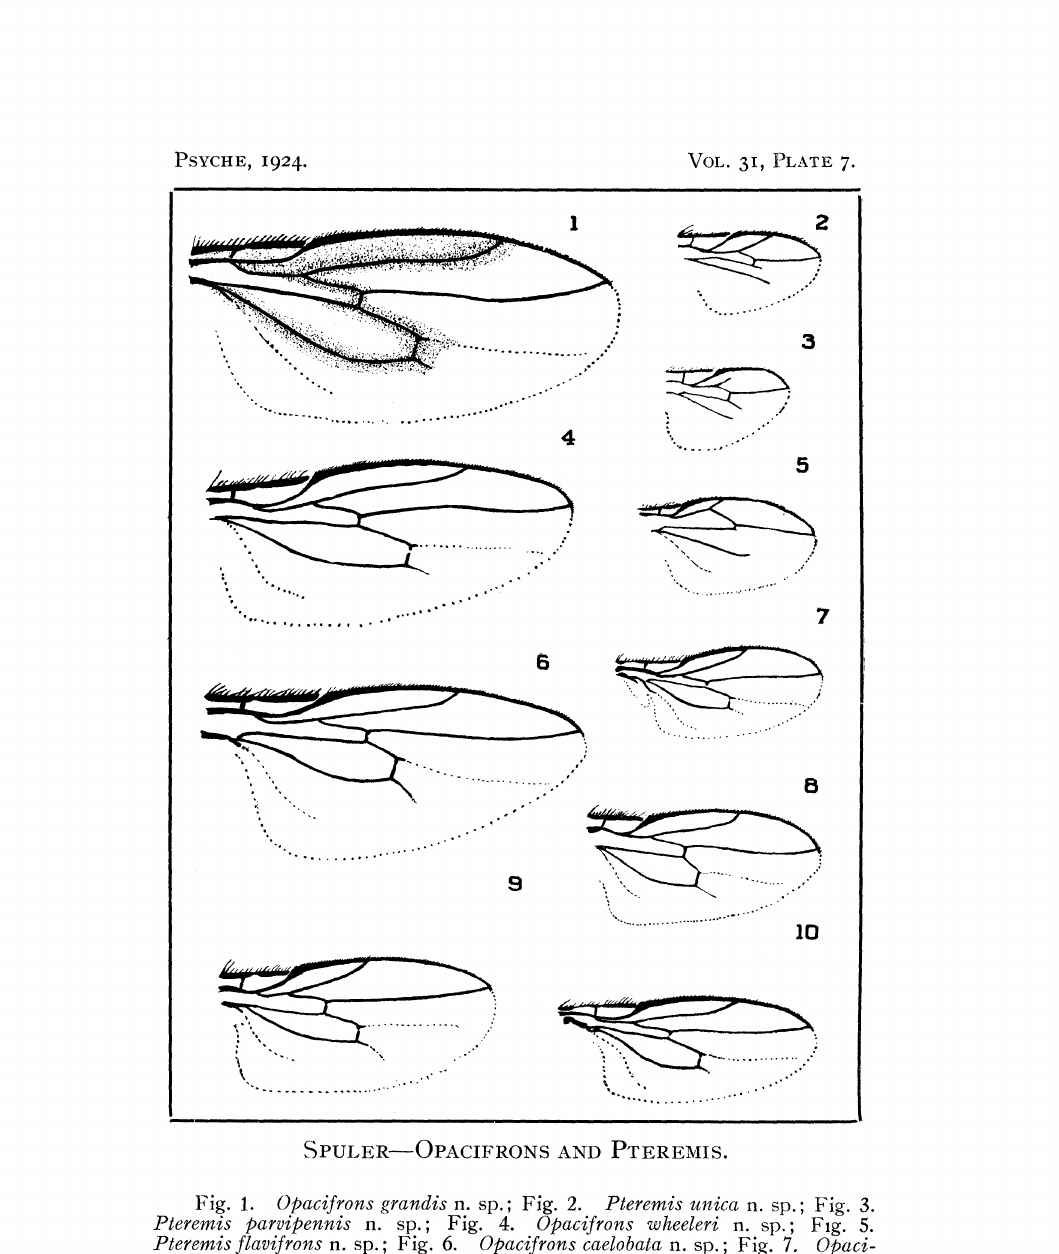
Fig. 1. Opacifrons grandis n. sp.; Fig. 2. Pteremis unica n. sp.; Fig. 3. Pteremis parvipennis n. sp.; Fig. 4. Opacifrons wheeleri n. sp.; Fig. 5. tteremis flavifrons n. sp.; Fig. 6. Opacifrons caelobata n. sp. Fig. 7. Opaci- frons coxata Stenh. Fig. 8. Opacifrons pellucida n. sp.; Fig. 9. Opacifrons convexa n. sp.; Fig. 10. Opacifrons sciaspidis n.